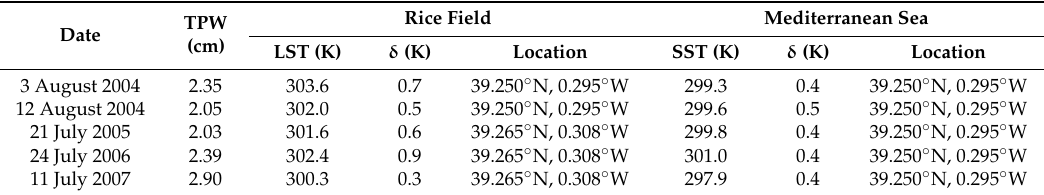
Table 3. Ground LST values and uncertainties measured in situ at the rice field concurrent to the ASTER overpass. MODIS-Terra SST product values (mean and standard deviation for 3 × 3 pixels centered at the location shown as latitude/longitude) from the Mediterranean Sea and the total precipitable water (TPW) are also given.